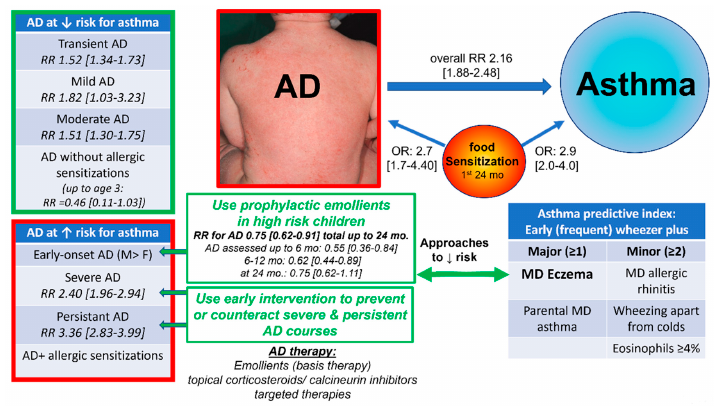
Figure 1. Atopic dermatitis with risk factors for the development of asthma, and implications for prophylactic and therapeutic intervention. Prophylactic emollients may contribute to the prevention or, at least, delay the early onset of AD within the first year of life. AD with early-onset, severe, and persistent disease course are at a higher risk for asthma. Early intervention and adequate treatment of AD might prevent the progress from mild and transient AD to severe and persistent forms, and in already existing severe AD, might contribute to downregulation of the severity and persistence of AD. This, in turn, might reduce the risk of the development of asthma = 95% Confidence interval, MD = physician diagnosis, mo=months, OR = odds ratio, RR = risk ratio. Effect sizes of risk factors [14,74], and the Asthma Predictive Index (API) estimating the probability of the development of asthma in a child with a history of wheezing [75–77], have been adapted from the literature. The Table with the API has been modified and adapted from: JOSÉ A. CASTRO-RODRÍGUEZ